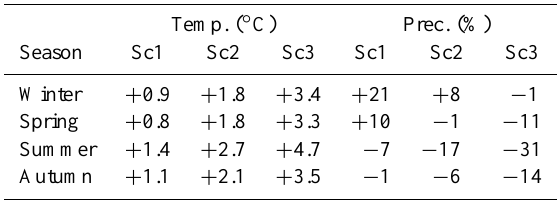
Fig. 7. Comparison of surface elevation and glacier extent calculated for Scenario 2 (median) using the ice flow model (M) and the ∆ h -parameterization (P) for Rhonegletscher. Coloured areas indicate ice coverage as calculated by the ice flow model. The colours refer to the difference in calculated surface elevation ( h M - h P ). Solid lines with contours show the glacier extent as predicted by the ∆ h -parameterization. The dotted line indicates the glacier outline in 2007. The percentage of ice volume relative to 2007 according to the parameterization is given.